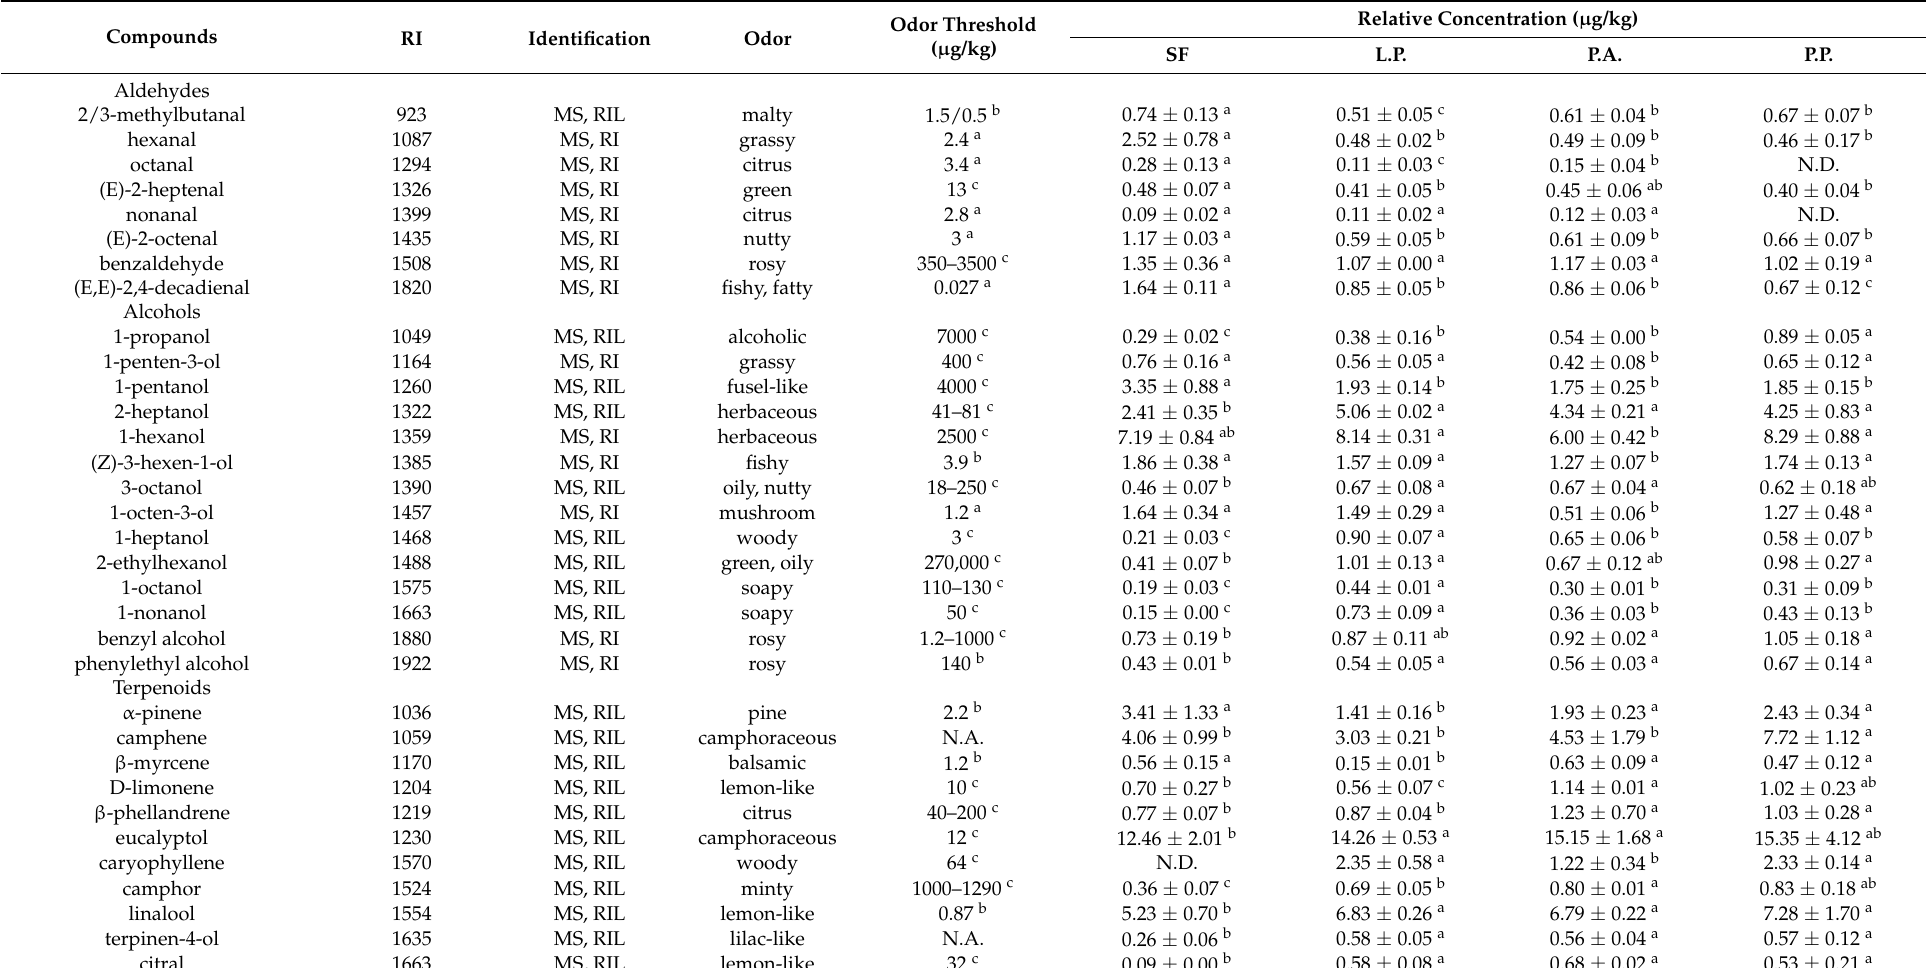
Table 3. Relative contents ( µ g/kg) of aroma compounds in Zhayu samples prepared by spontaneous fermentation (SF) and fermented with 10 9 cfu/100 g of L. plantarum (L.P.), P. acidilactici (P.A.), and P. pentosaceus